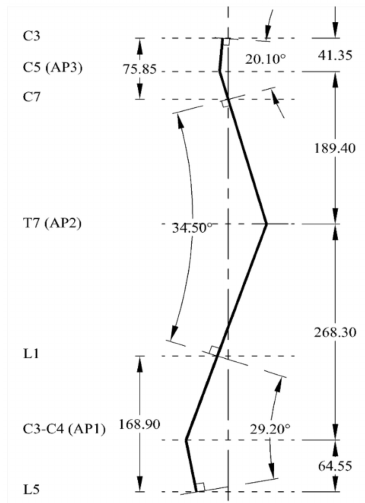
Figure 4. Established curvature line mimicking the human spine.